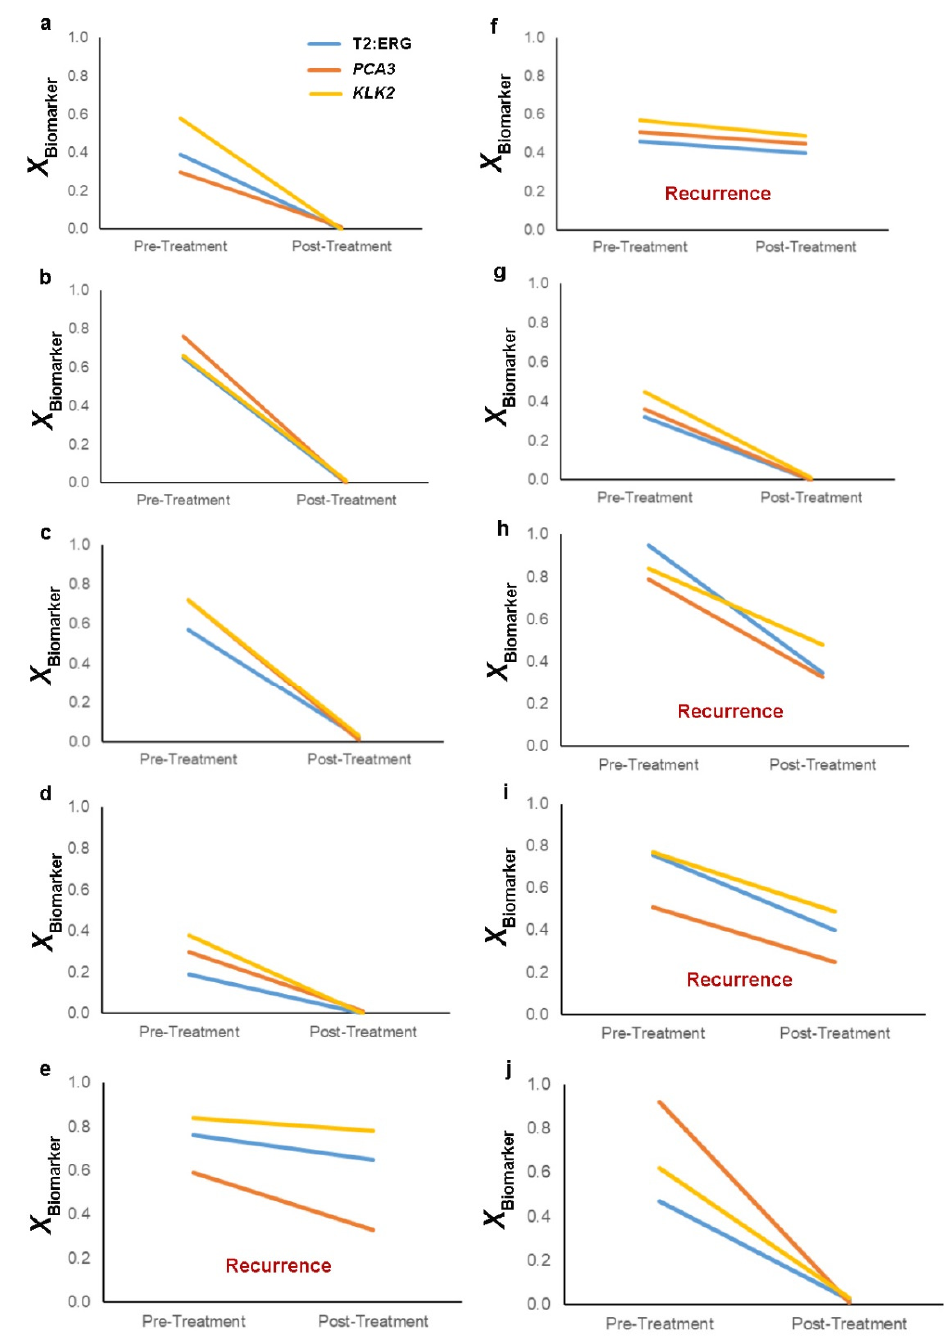
Figure 4. Non-invasive minimal residual disease monitoring in ( a – j ) pre- and post-treatment urinary liquid biopsy samples for 10 prostate cancer patients.